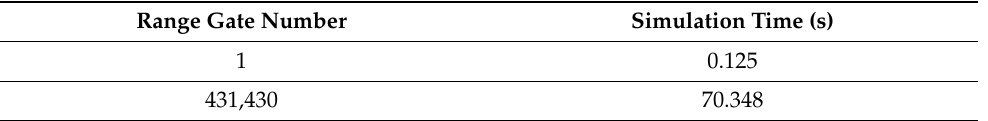
Table 2. The time of echo signal simulation.